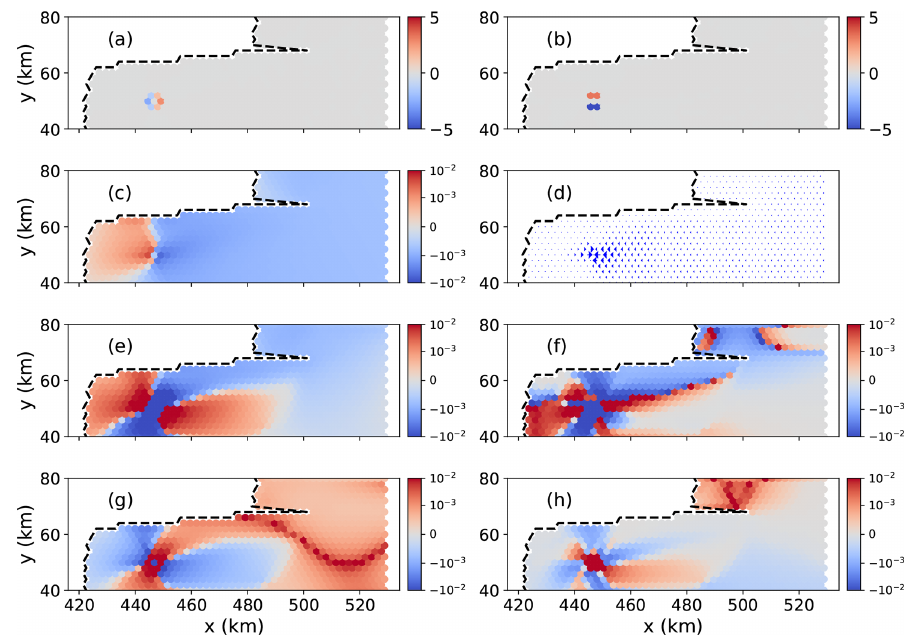
Figure 6. An example of the local change (ratio, in percent) in (a) the ice thickness gradient in x , (b) ice thickness gradient in y , (c) ice speed, (d) ice velocity (relative), (e, f) principal strain rates, and (g, h) buttressing number following a local perturbation to the ice shelf thickness. In (e) and (g) , changes (colors) are associated with the n p1 direction, and for (f) and (h) changes are associated with the n p2 direction.